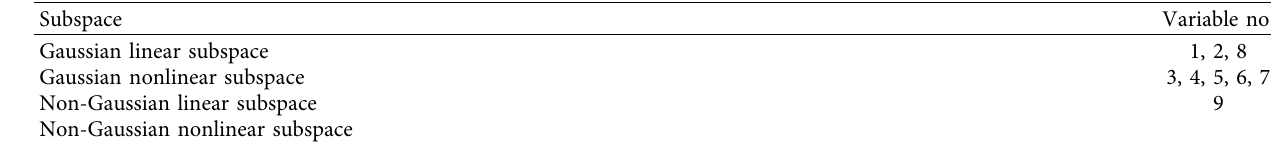
Table 5: CSTR process variable division in each